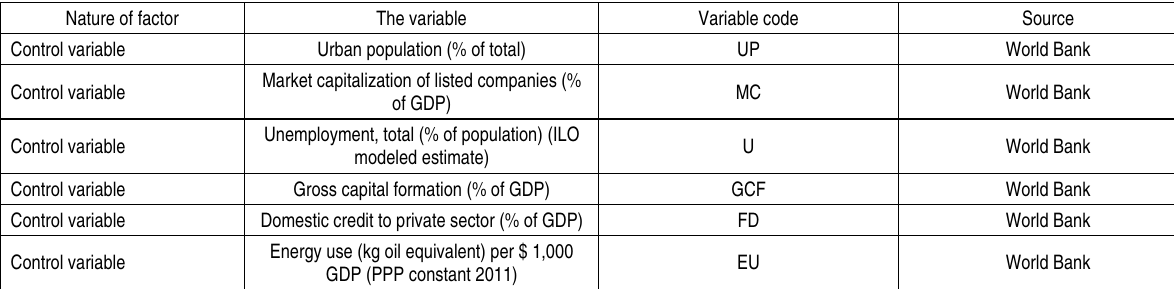
Table 1 (cont.). The different variables